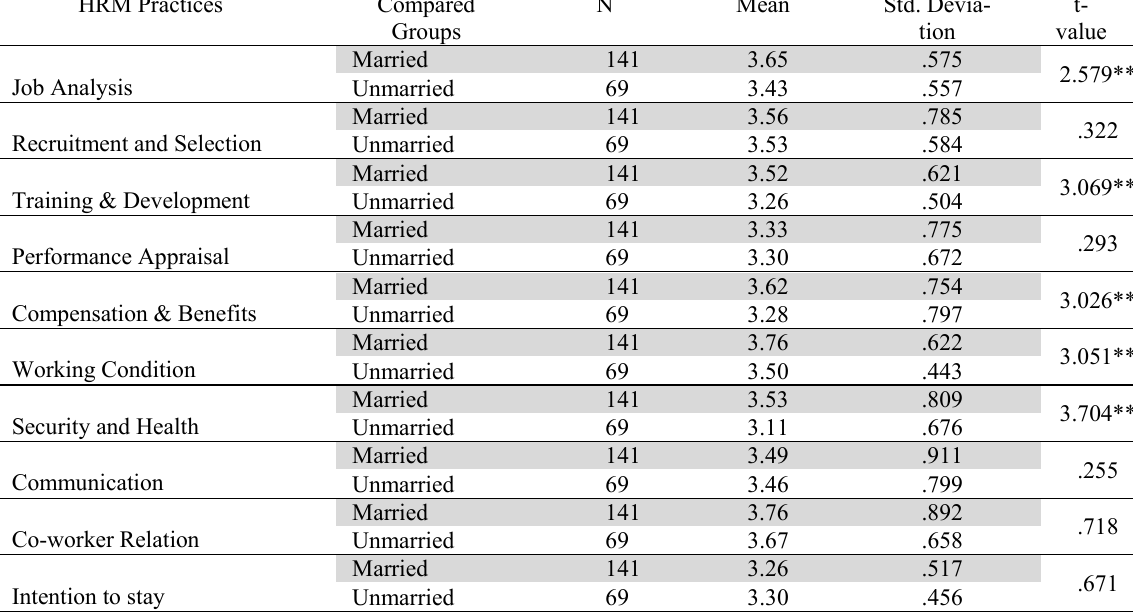
Table 1 Mean, SD and t-value of social status group of telecom employees on different HRM practices HRM